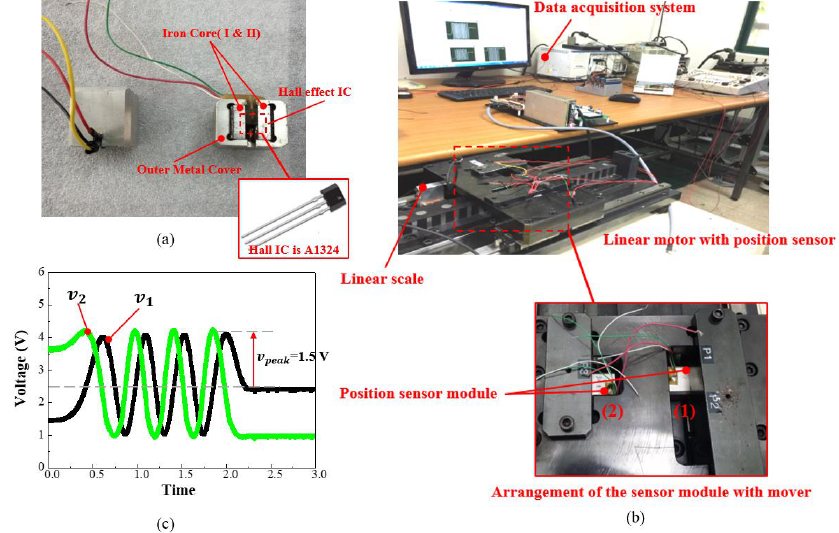
Figure 11. ( a ) Manufactured sensor module; ( b ) Experimental setup with sensor module installed over the linear motor and the data acquisition system; ( c ) Sensor voltage signal.